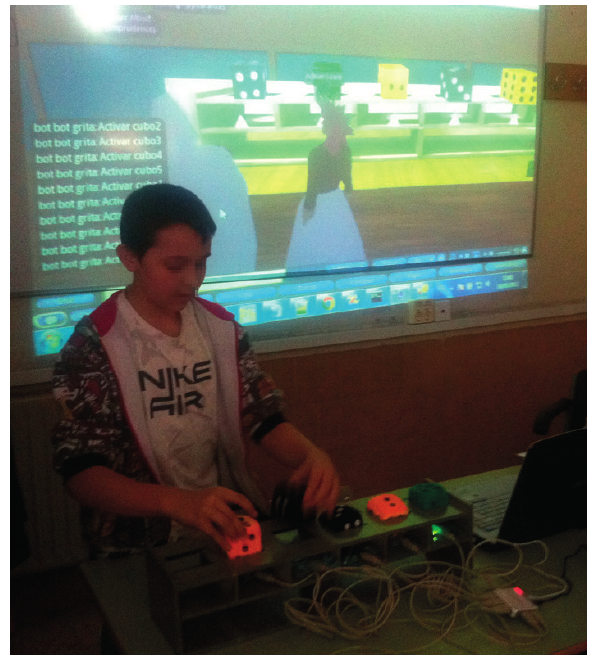
Figure 8. A student using